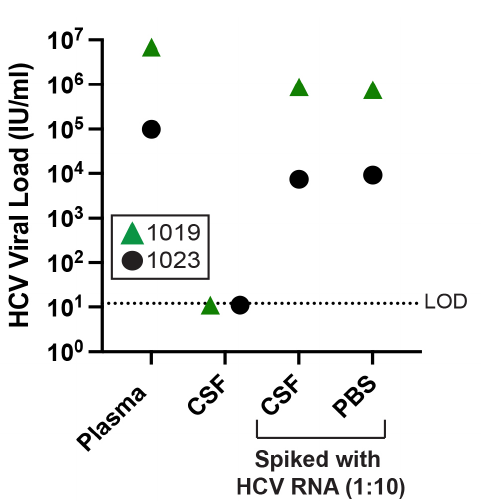
Figure 2. HCV is detectable in spiked CSF and PBS. HCV+ blood from 2 participants, 1019 (green triangles) and 1023 (black circles), was used to spike patient matched CSF as well as PBS. Ten percent plasma was mixed with 90% CSF or 90% PBS, and an HCV viral load was performed on these spiked samples along with pure plasma and pure CSF. The limit of detection (LOD) for the HCV VL assay is shown with a dashed